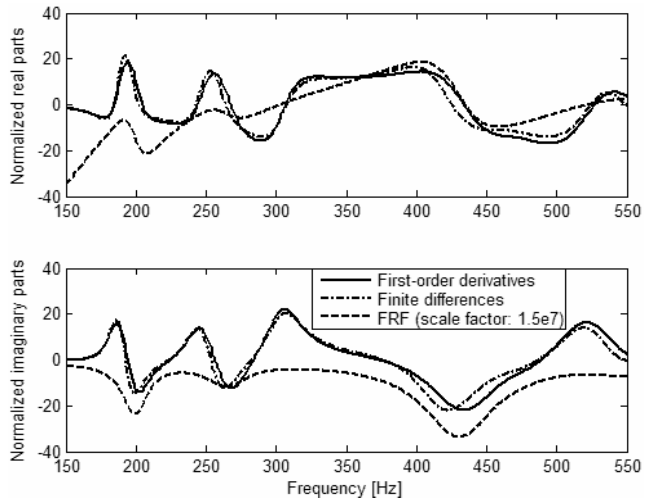
Fig. 8. Sensitivities of the FRF H II ( ω,T,p ) with respect to temperature for a nominal temperature of 308 K. H ω, T + Δ T, p ) ∼ = H II (